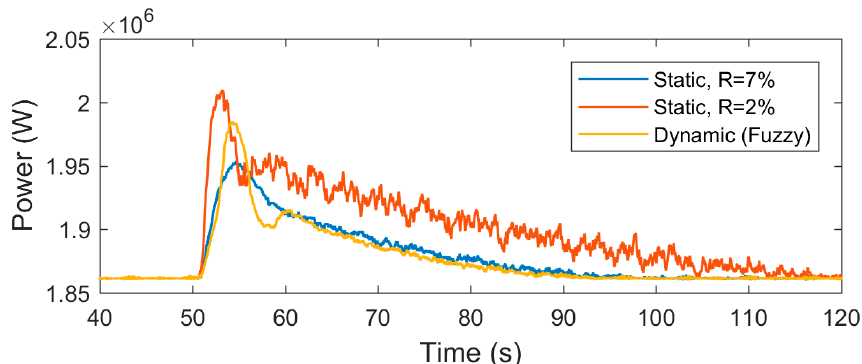
Figure 14. Rotor speed (small ROCOF).